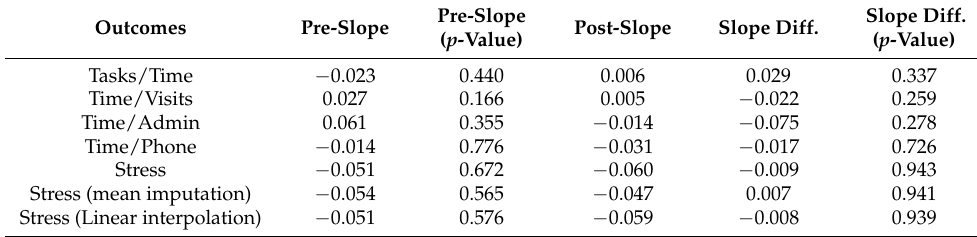
Table 5. Interrupted time series analysis, change in trend post- and pre-intervention slopes.